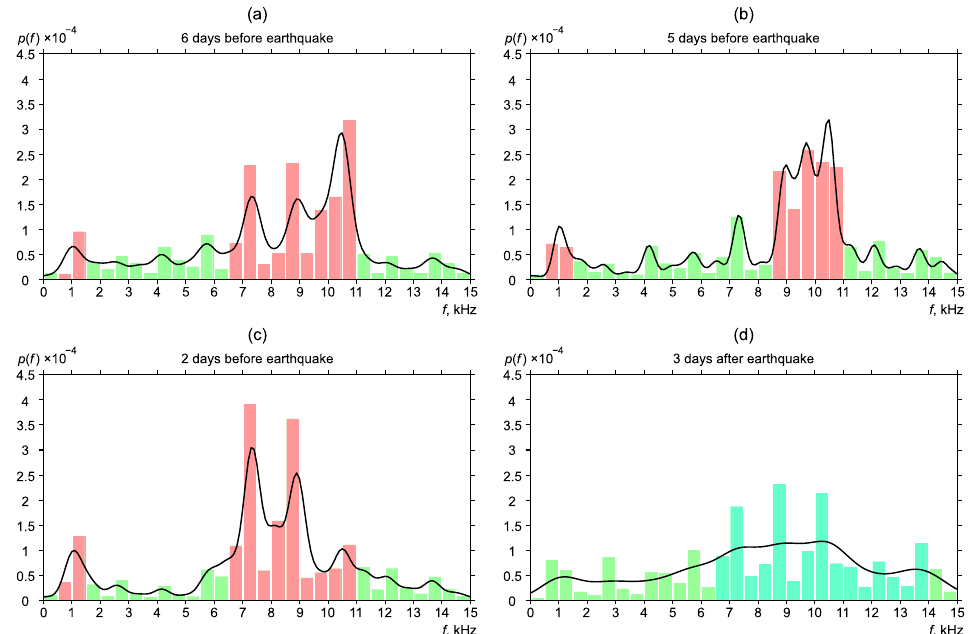
Figure 8. Dynamics of the probability density of distribution of the most powerful frequencies of geoacoustic pulses before and after the earthquake No.